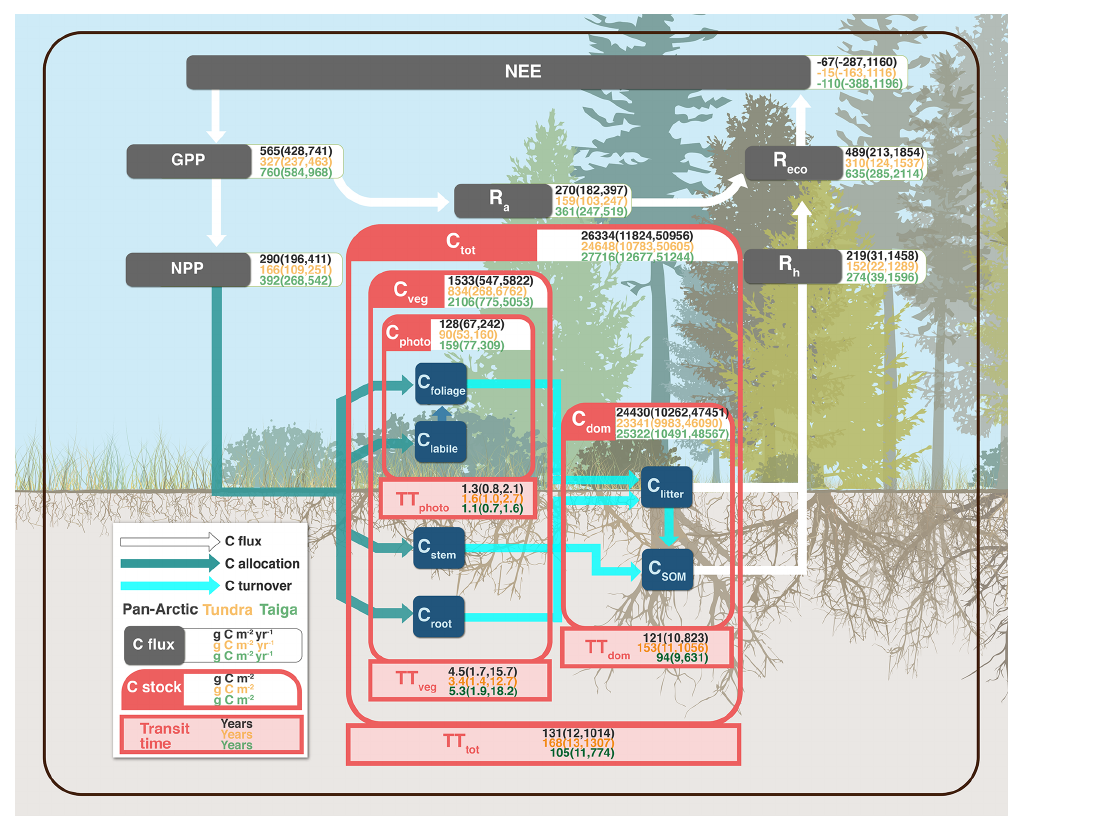
Figure 1. Schematic diagram of the terrestrial C processes modelled in CARDAMOM for the pan-Arctic (black values), tundra (yellow values), and taiga (green values) domains. The values characterise the median for the 2000–2015 period and the parentheses delimit the 90% confidence interval. C processes represented include flows for C fluxes in white (NEE, net ecosystem exchange; GPP, gross primary produc- tion; NPP, net primary production; R eco , ecosystem respiration; R a , autotrophic respiration; R h , heterotrophic respiration), C allocation in dark green (to labile, leaf, stem and root), and C turnover in cyan (from leaf, wood, roots, and litter). C stocks are represented in dark blue boxes (labile, leaf, stem, root, litter, and SOM, soil organic matter) and aggregated into photosynthetic ( C photo = leaf + labile), vegetation ( C veg = leaf + labile + wood + roots), soil ( C dom = litter + SOM), and total ( C tot = C photo + C veg + C dom ) C stocks in red boxes. Analogy, transit times (TT) are also aggregated into photosynthetic (TT photo = leaf + labile), vegetation (TT veg = leaf + labile + wood + roots), soil (TT dom = litter + SOM), and total (TT tot = TT photo + TT veg + TT dom ) C transit